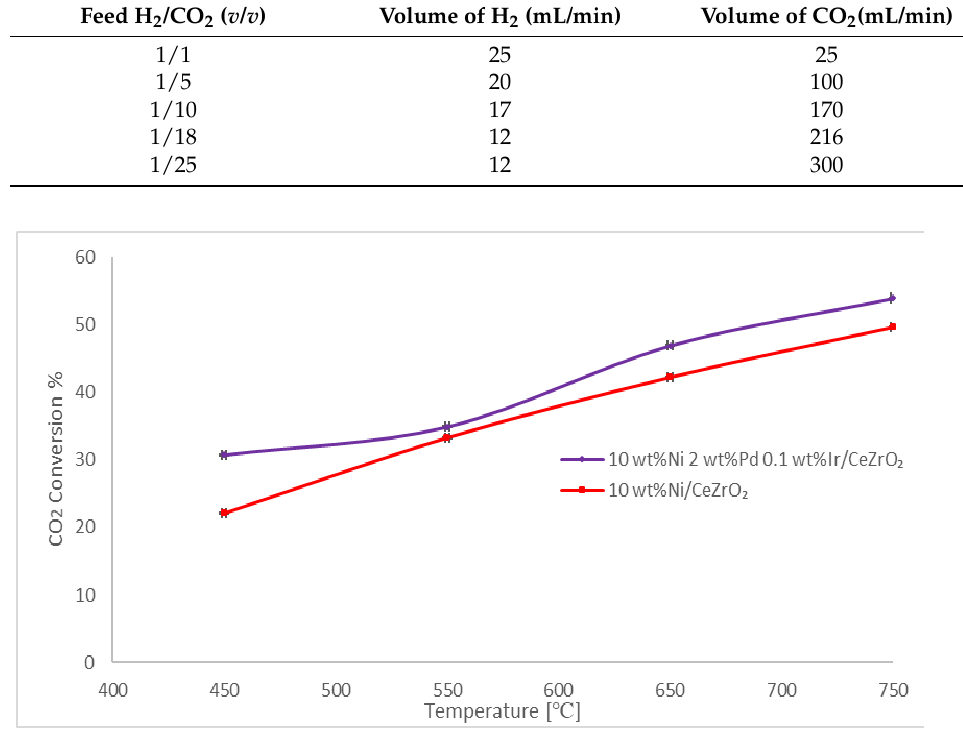
Figure 5. CO 2 conversion of 10 wt%Ni 2 wt%Pd 0.1 wt% Ir/CeZrO 2 and 10 wt%Ni/CeZrO 2 at